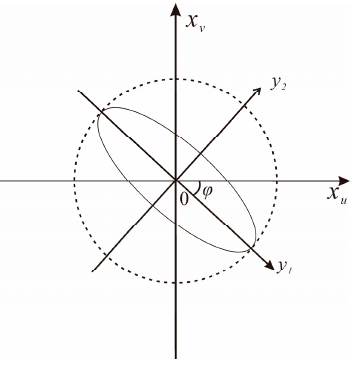
Figure 4. Coordinate axis rotation